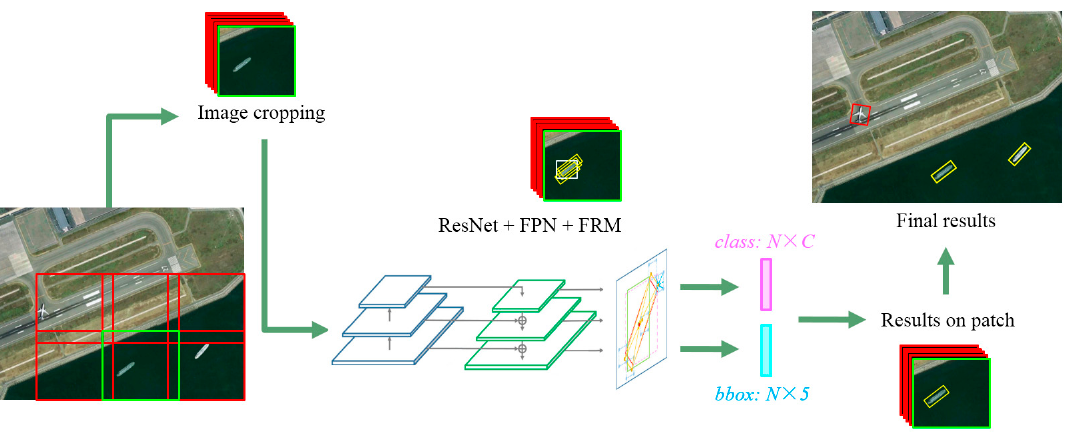
Figure 3. Flowchart of aircraft detection (R3Det-based).